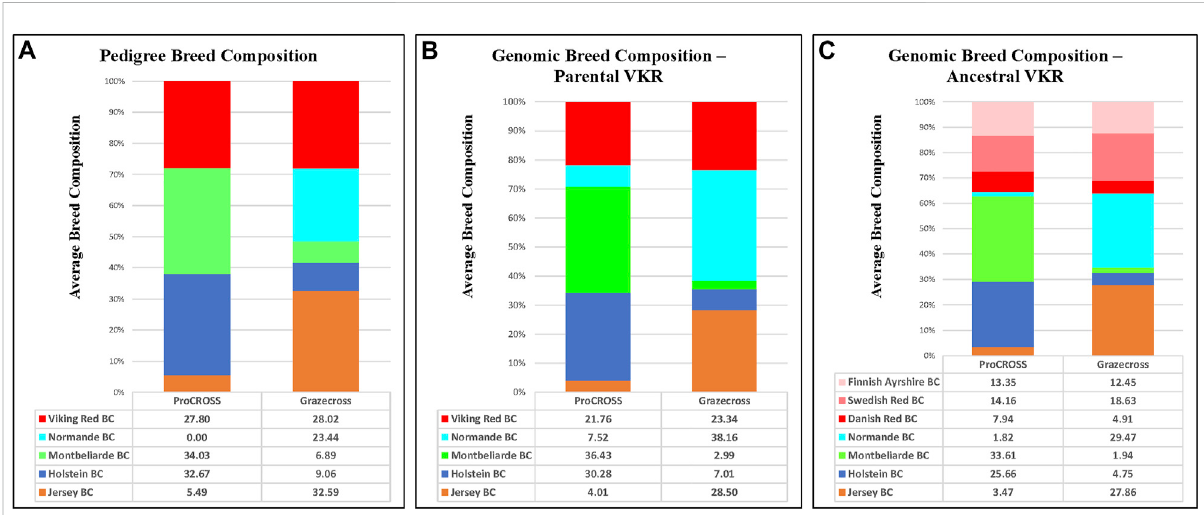
FIGURE 3 Average breed composition using pedigree or genomic data; parental or ancestral VKR representation. (A) Pedigree based breed composition (B) Genomic based breed composition with commercial VKR as reference panel (C) Genomic based breed composition with ancestral VKR as reference panel.